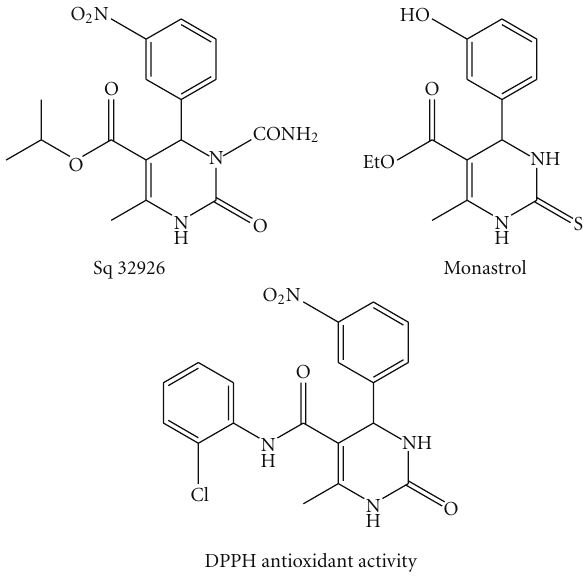
Figure 1: Some biologically active dihydropyrimidinones derivatives.